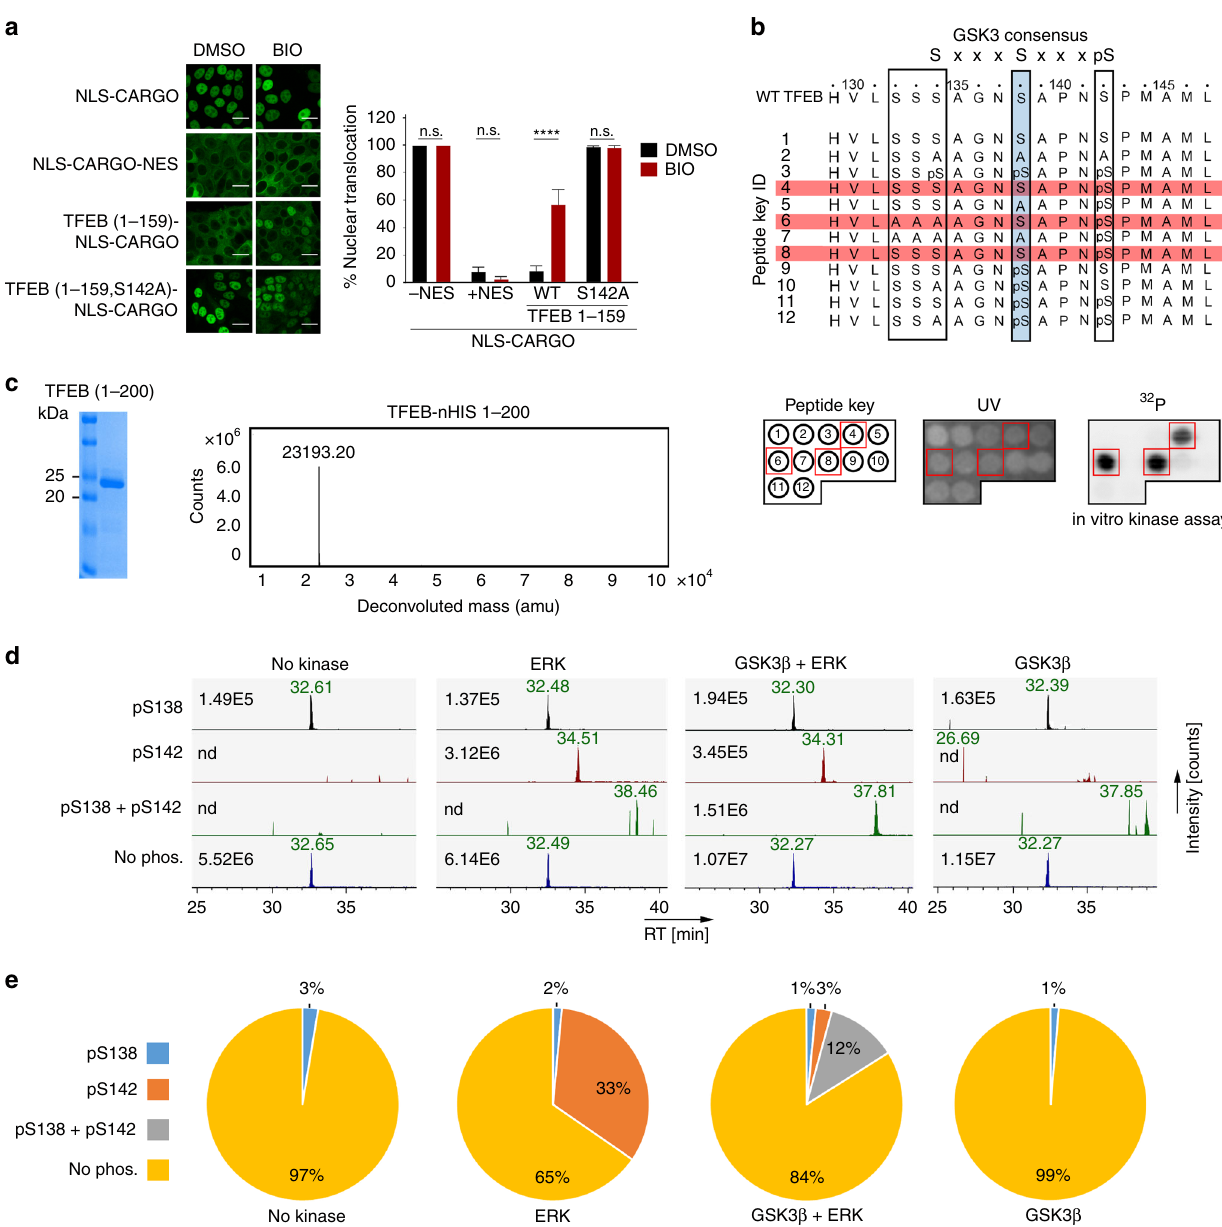
Fig. 4 Phosphorylation at S142 primes for GSK3 β phosphorylation at S138. a Fluorescence images of cells expressing indicated WT and mutant cargo vectors in the presence and absence of BIO (10 μ M). n > 50 cells per condition. Error bars = SD. Scale bar = 20 μ M. **** p < 0.0001, n.s. not signi fi cant. b TFEB amino acids 129 – 152 showing the GSK3 β consensus sequence. The S138 GSK3 β site is highlighted in blue, the ERK/mTOR phosphorylation site S142 is boxed, as are three additional potential GSK3 β sites that could be primed by phosphorylation at S138. Peptides 1 – 12 were spotted onto a membrane (see key corresponding to peptides in lower left panel) and subject to GSK3 β phosphorylation in vitro. Peptides highlighted in red were phosphorylated by GSK3 β . Lower panels: Peptide key corresponding to peptides above spotted onto a membrane (left) and visualized by UV (middle). The result of the GSK3 β kinase assay is shown in the right panel and the red boxes correspond to phosphorylated peptides highlighted in red above. c Coomassie-stained gel of bacterially expressed and puri fi ed 6xHIS-tagged TFEB amino acids 1 – 200 (left) and associated Mass Spec spectrum (right). d Extracted ion chromatograms of tryptic peptides covering S138 and S142 in their differential phosphorylation states after indicated kinase treatment. A peptide with a single phosphorylation on S138 was detected at low intensity in all samples, including those not treated with GSK3 β , while a peptide with a phosphorylation event on S142 was only detected in the ERK and GSK β + ERK treated samples. Peptides dually phosphorylated on both S138 and on S142 were detected only after GSK β + ERK treatment. Numbers represent maximum ion count for each peptide/phospho-peptide. e Quanti fi cation of TFEB in vitro kinase/ Mass Spec data. The pie-charts illustrate the signal contribution of each (phospho-)peptide variant to total signal intensity covering the analyzed phosphorylation locus after kinase treatments. Assuming that each peptide variant has identical ionization characteristics, the charts re fl ect the stoichiometry of the different phospho-proteoforms of TFEB after kinase